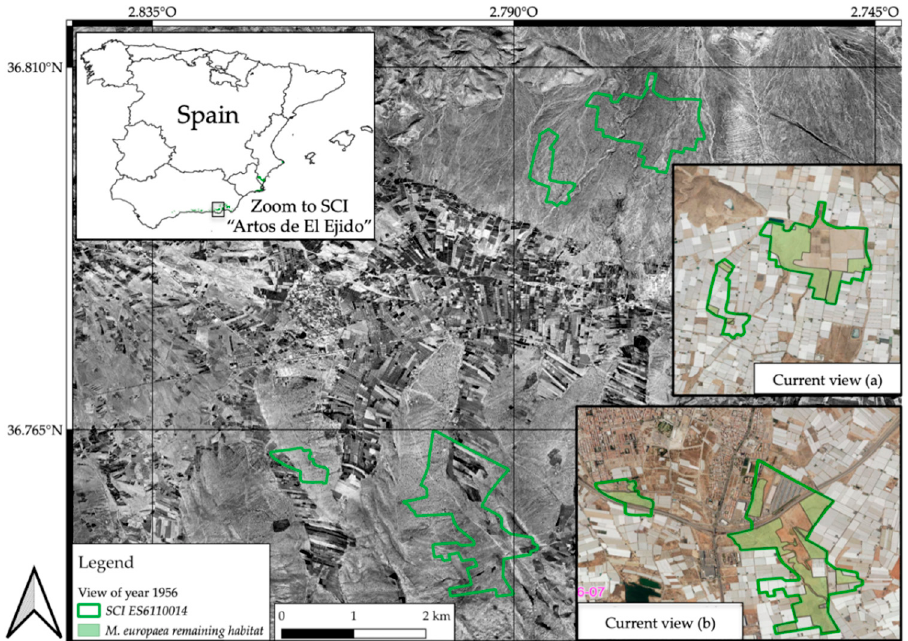
Figure 4. Future distribution models for M. europaea . Plots of the potential habitat projected into the future according to the representative concentration pathways: ( a ) RCP2.6; ( b ) RCP4.5; ( c ) RCP6.0; ( d ) RCP8.5.